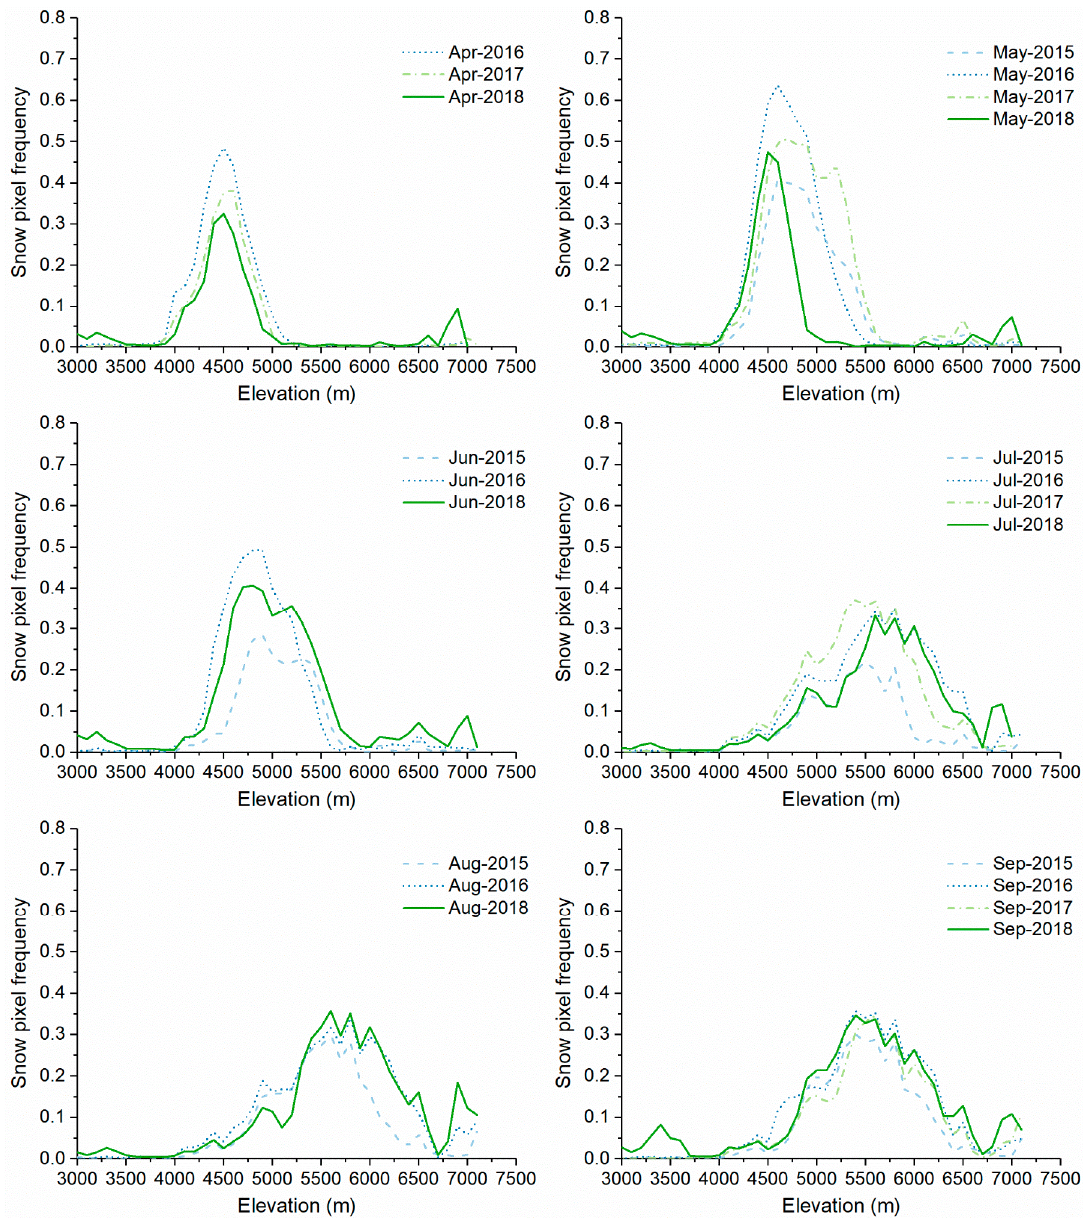
Figure 8. The wet snow frequency at different elevations during the snowmelt season from 2015 to 2018 based on Sentinel-1 ascending/descending images.